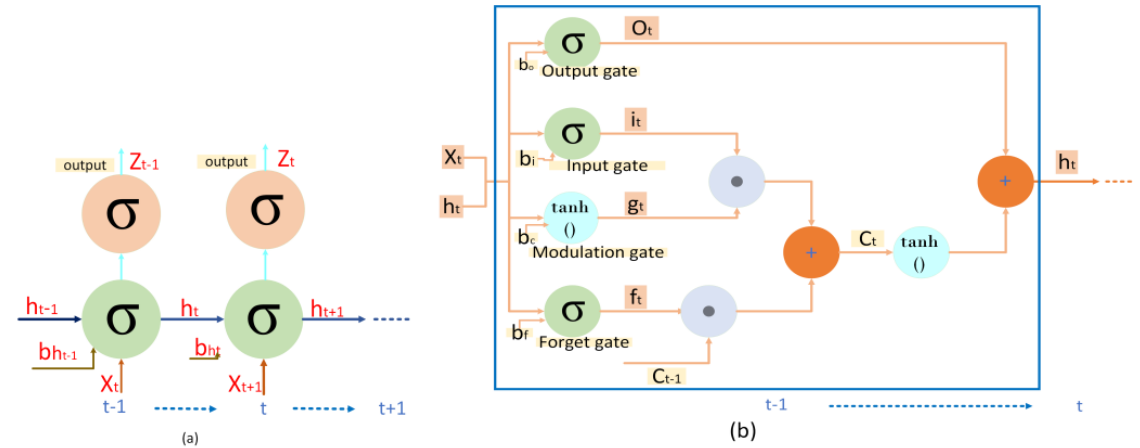
Figure 2. ( a ) RNN and ( b ) LSTM decoder architecture (RNN: recurrent neural network, LSTM: long short-term memory).